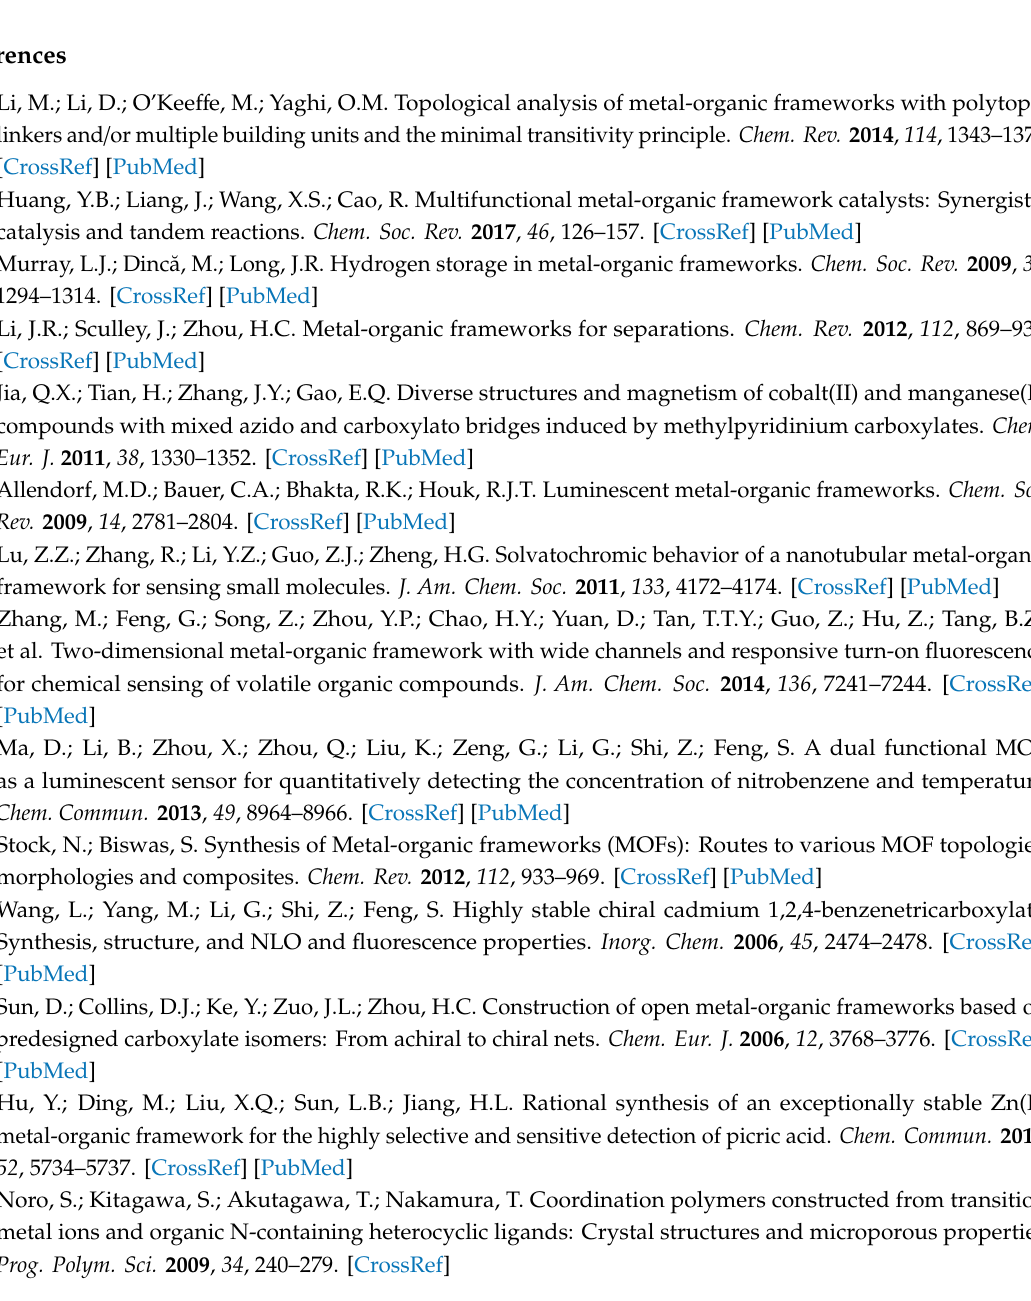
Table S1: Selected bond lengths (Å) and bond angles ( o ) for